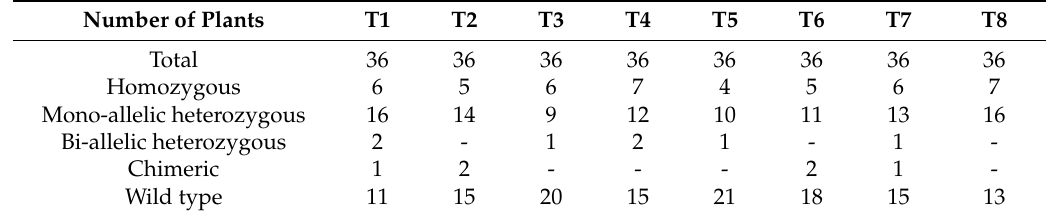
Table 1. The number of plants detected and mutation frequency in T 0 generation.